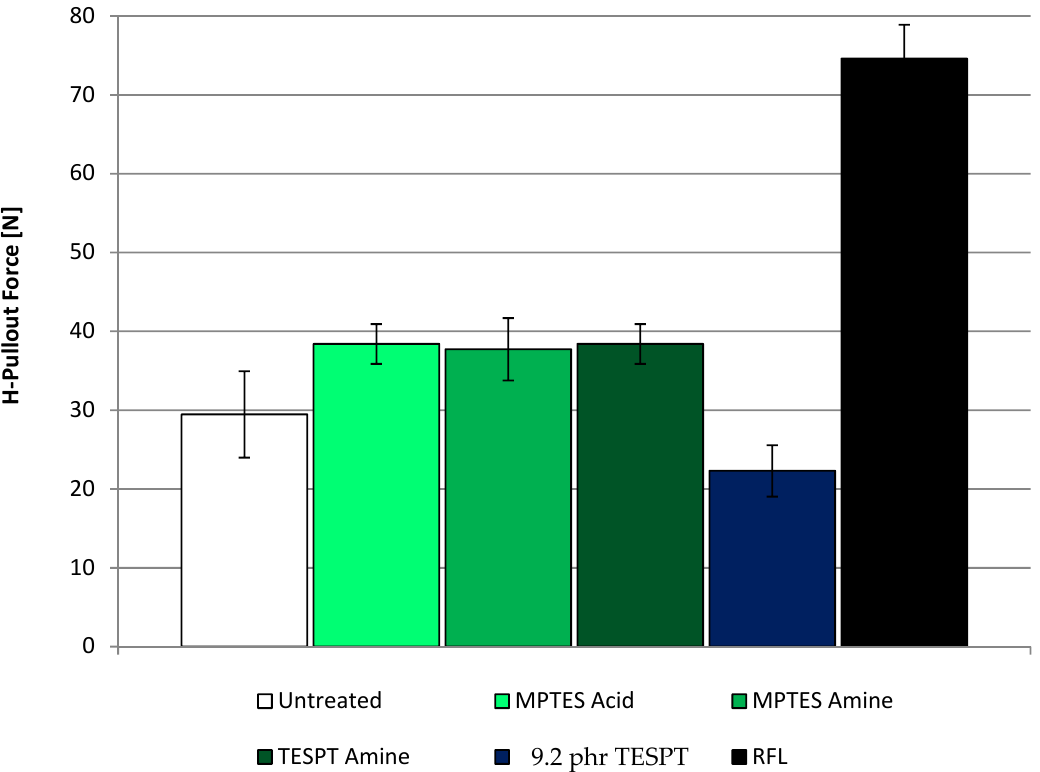
Figure 7. H-pullout results for TEOS-plasma-coated polyester cords.